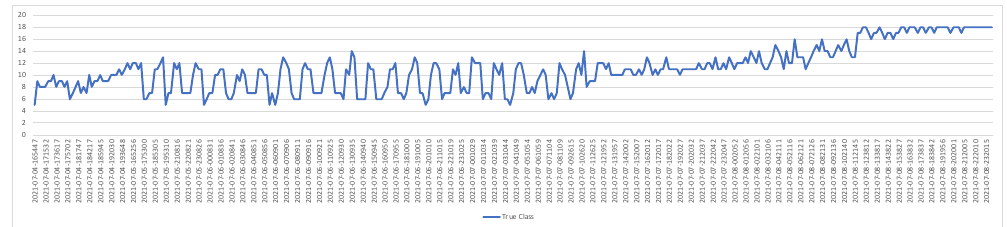
Figure 11. Correct number of fertile eggs for the second test dataset.